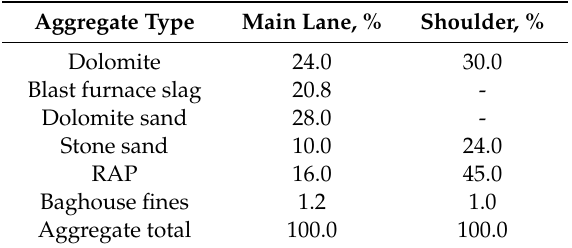
Table 1. Summary of raw aggregate and recycled asphalt pavement (RAP).